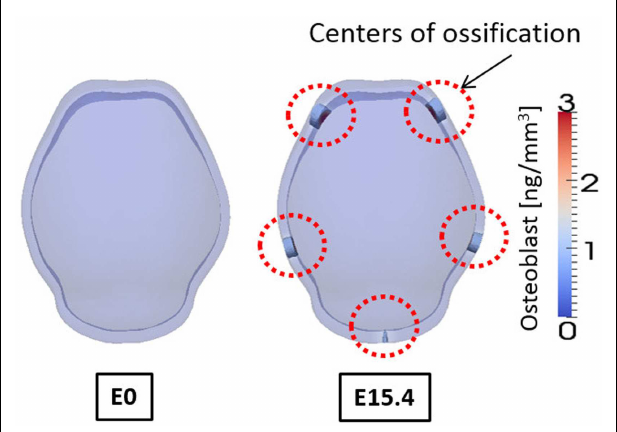
FIGURE 10 | Concentration of osteoblast at embryonic day 0 and 15.4 from simulation result . Osteoblasts are differentiated in the regions where concentration of activator is high. And these regions of osteoblasts can develop into mineralized bone that is primary centers of ossification. Osteoblasts are not differentiated on the top of the domain although concentration of activator is high there, due to the spatial effect on cell differentiation in our model. Five primary centers of ossification and this agree well with experimental observation showing two frontal, two parietal, and a single interparietal bones.